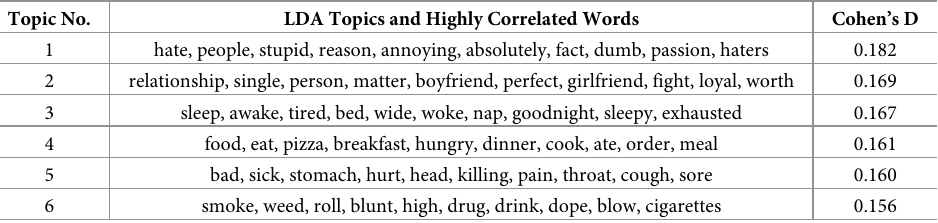
Table 2. Results from LDA analysis for users who express loneliness on Twitter and are between the ages of 23 and 29. Topic